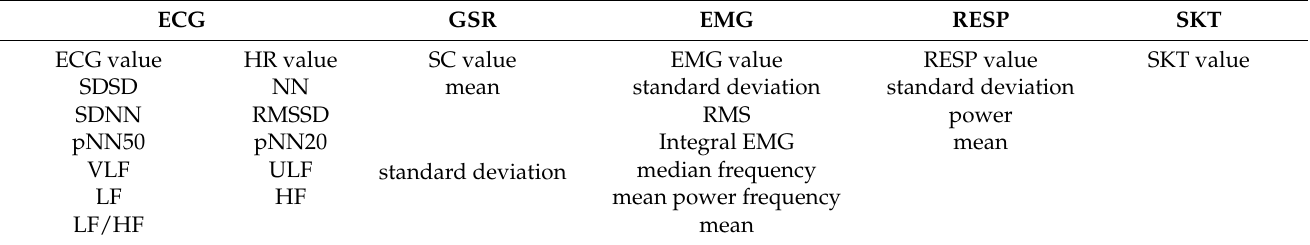
Table 5. Multi-modal